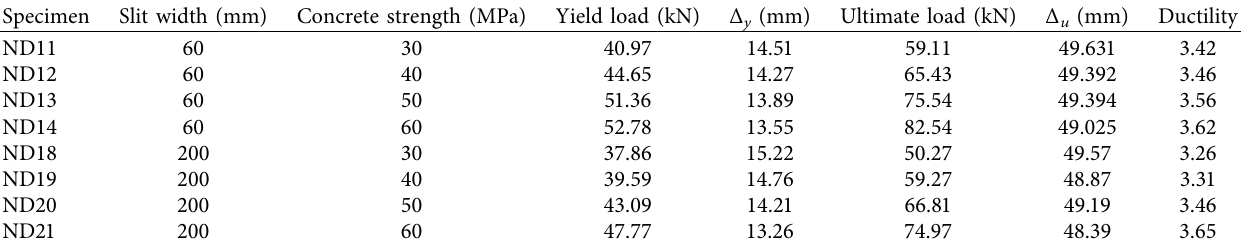
Table 9: Loads, displacement and ductility of different concrete strength.